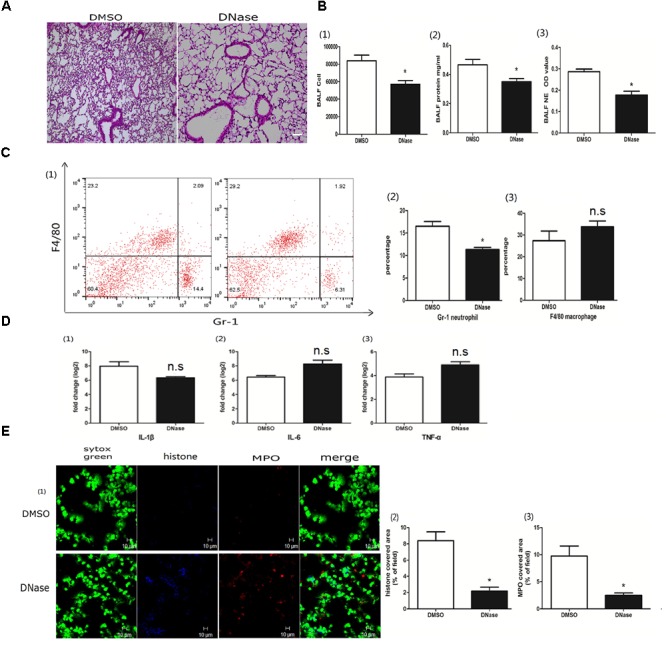
DNase protected the lung from poly I:C-induced NETs. (A) Infiltration of inflammatory cells and interstitial edema in the lung lobe were reduced in the ALI model mice upon DNase treatment, bar = 100 μm; (B-1) cells were counted in the BALF, ∗p < 0.05; (B-2) protein concentration in the BALF, ∗p < 0.05; (B-3) neutrophil elastase (NE) activity was evaluated in the BALF, ∗p < 0.05; (C) flow cytometry analysis of the BALF cells, ∗p < 0.05; (D) inflammatory cytokines IL-1β, IL-6, and TNF-α in the lung were quantified using qRT-PCR, ∗p < 0.05; (E) NETs were observed and quantified in lung tissues from mice administered poly I:C and DNase.